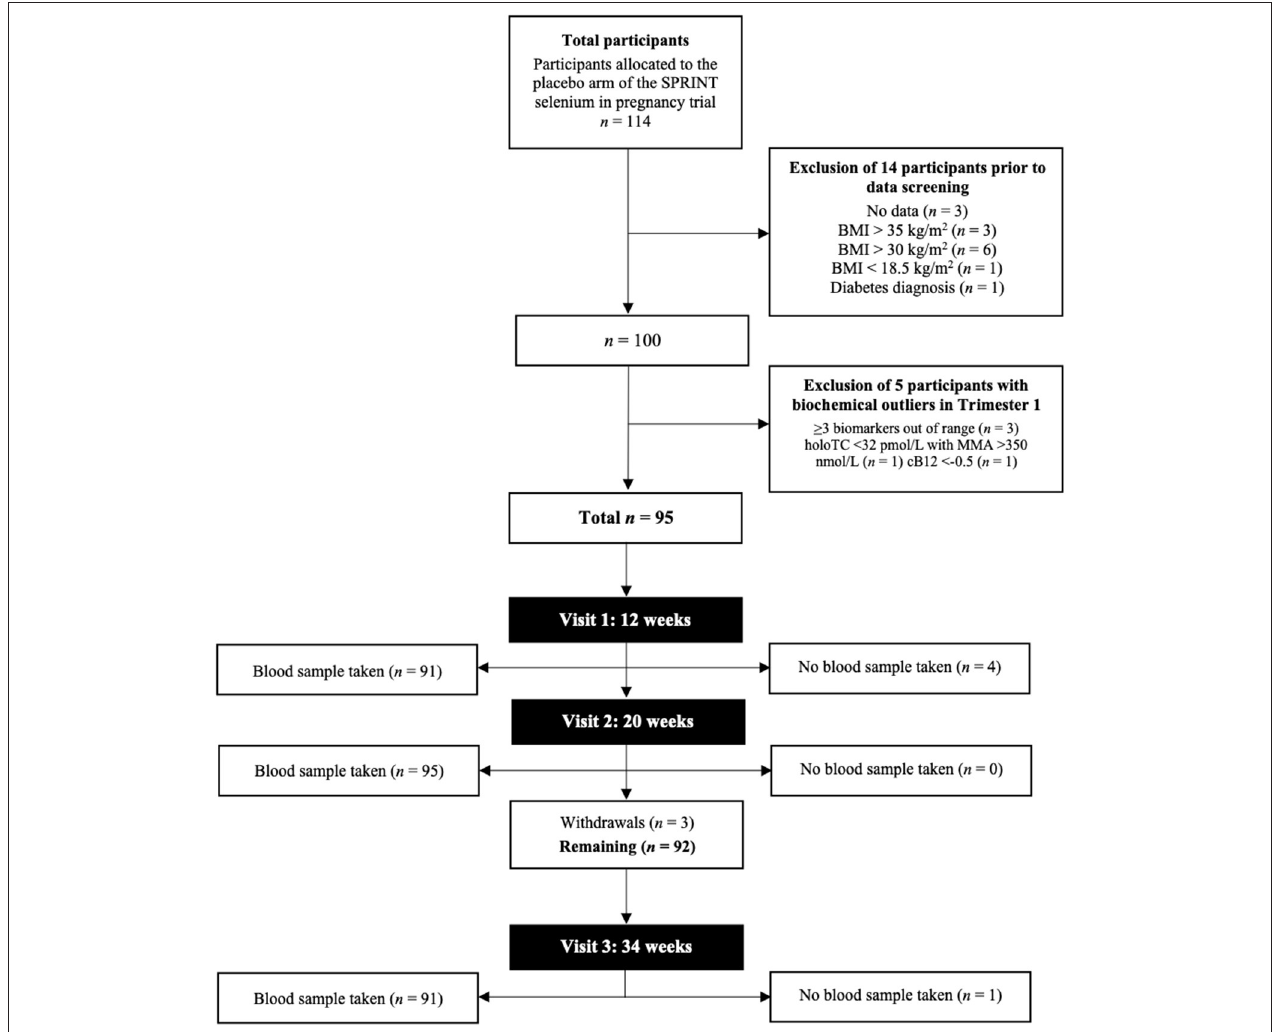
FIGURE 1 | Flowchart of the study cohort selection from the SPRINT study placebo arm. BMI, body mass index; cB 12 , combined indicator of vitamin B 12 status; HoloTC, holotranscobalamin; MMA, methylmalonic